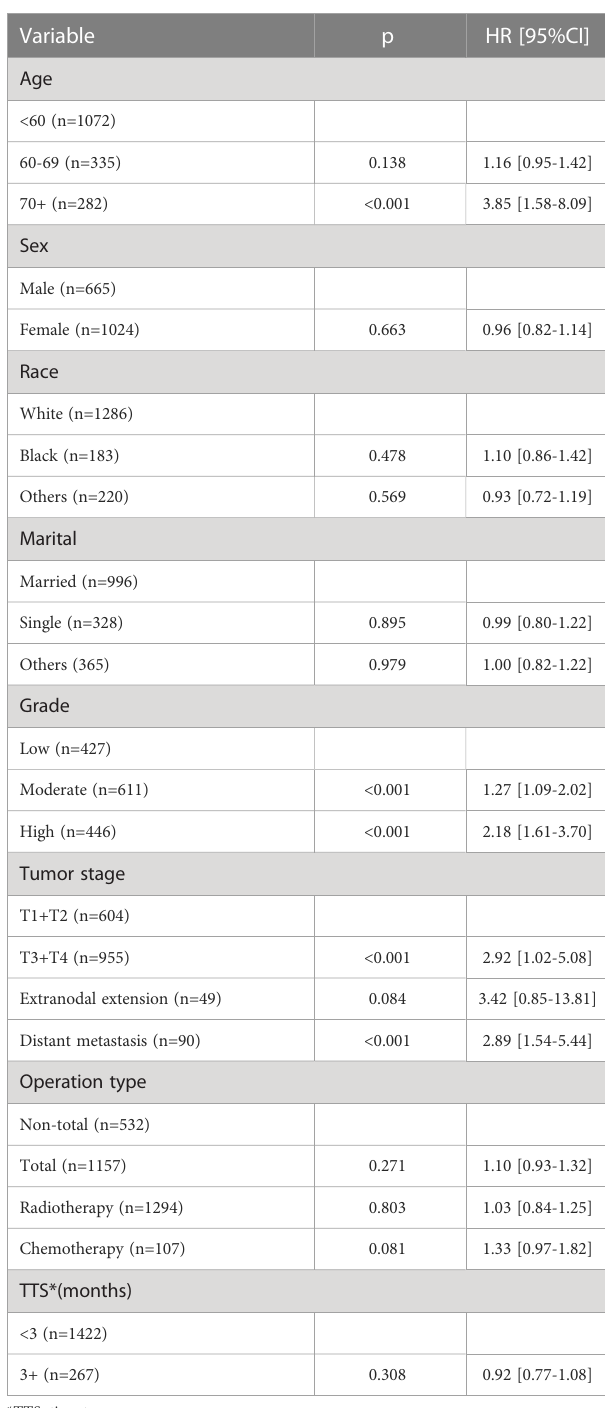
TABLE 2 Univariate cox analysis of the impact of clinicopathologic variables on overall